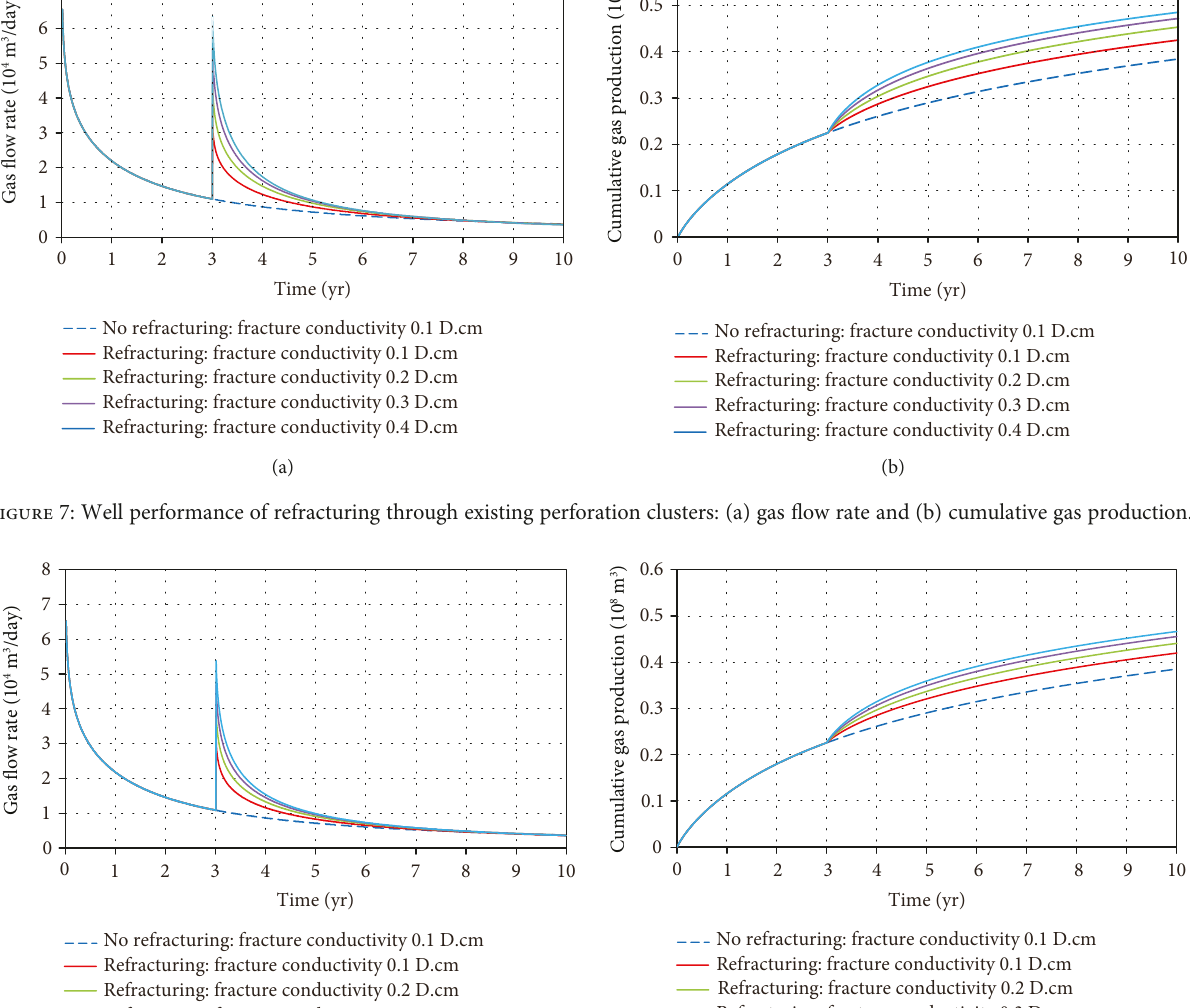
No refracturing: fracture conductivity 0.1 D.cm